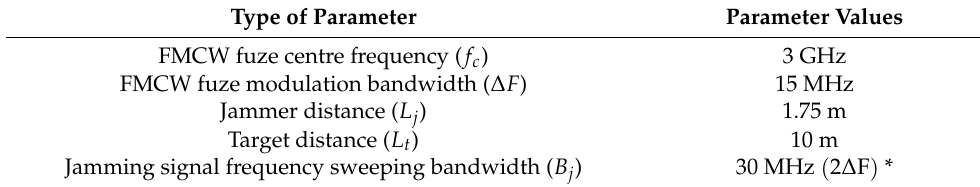
Table 1. Experimental parameter settings. Type of Parameter